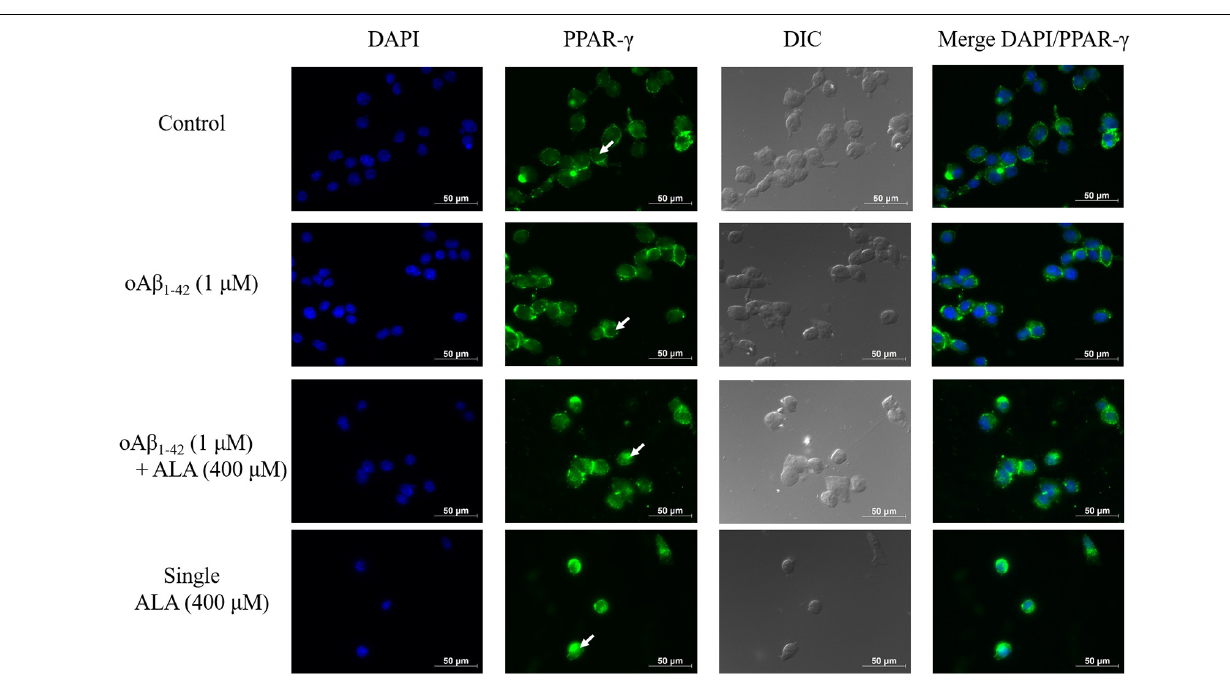
FIGURE 7 | Alpha-lipoic acid caused PPAR- γ translocation from the cytoplasm to the nucleus. BV-2 cells were pretreated with or without ALA (400 µ M) for 30 min, followed by vehicle or oA β 1 − 42 treatment for 24 h. After treatment, BV-2 cells were immunostained with PPAR- γ antibody (green) and the nuclei were stained with DAPI